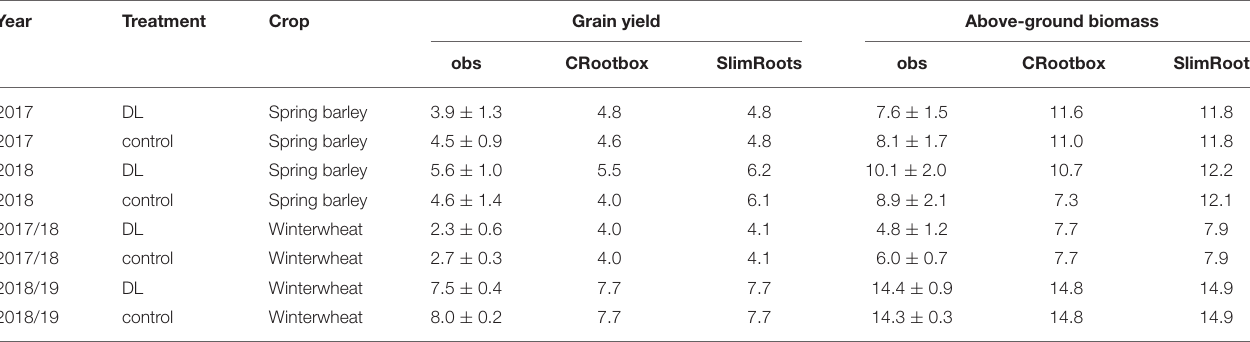
TABLE 2 | Observed (obs, mean ± standard deviation) and simulated spring barley (cultivar “Simba”) and winter wheat (cultivar “Desamo”) dry matter grain yield and above-ground biomass, both in t ha − 1 , in 2017, 2018, and 2019 for the treatment with strip-wise subsoil loosening (DL) at the melioration strip and the control treatment (CF1-1,